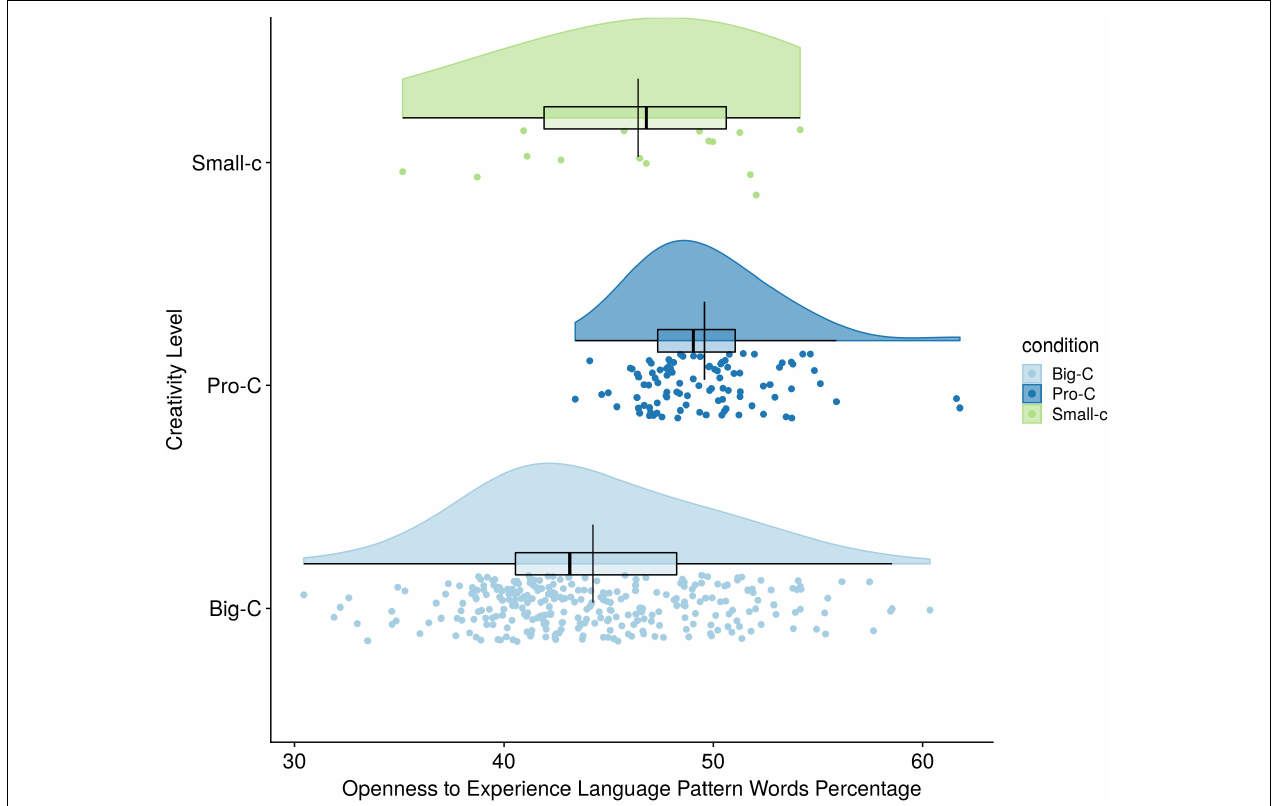
FIGURE 4 | Creativity level differences on openness to experience language pattern use.